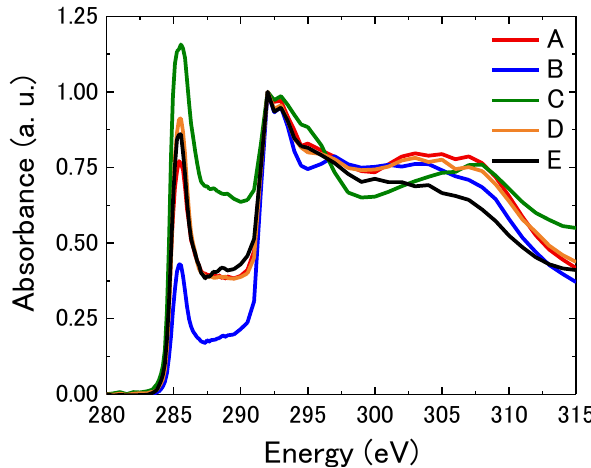
Figure 2. Average C K -edge spectra of the areas A to E shown in Table 3f.